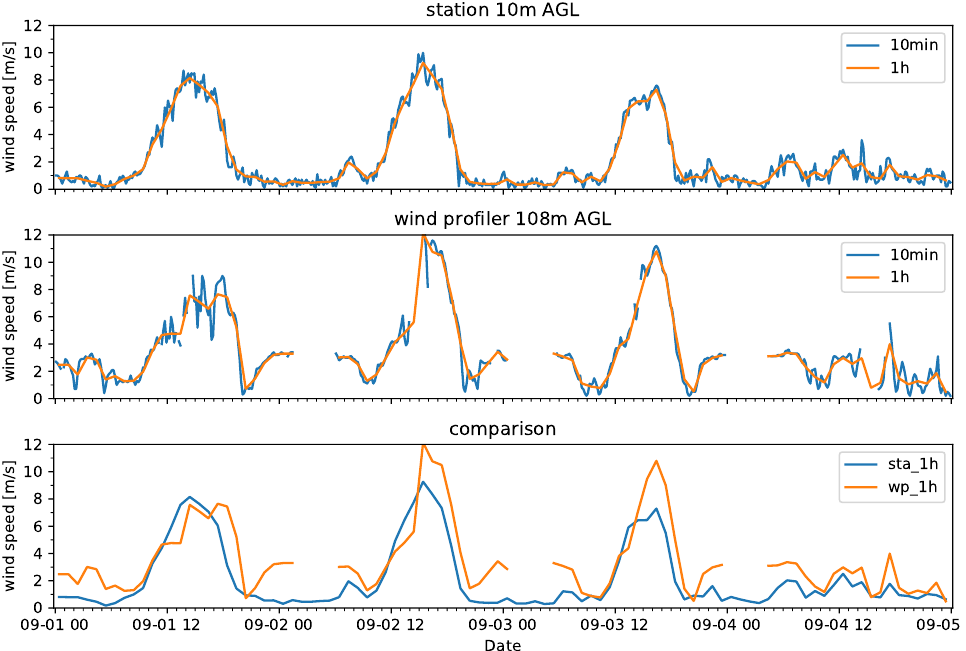
Figure 3. Time series of 10min and hourly averaged wind speed for the weather station at 10m AGL ( upper panel ), the wind profiler at 108m AGL ( middle panel ), and comparison of hourly averaged wind speed for the wind profiler (wp_1h) and the weather station (sta_1h) ( lower panel